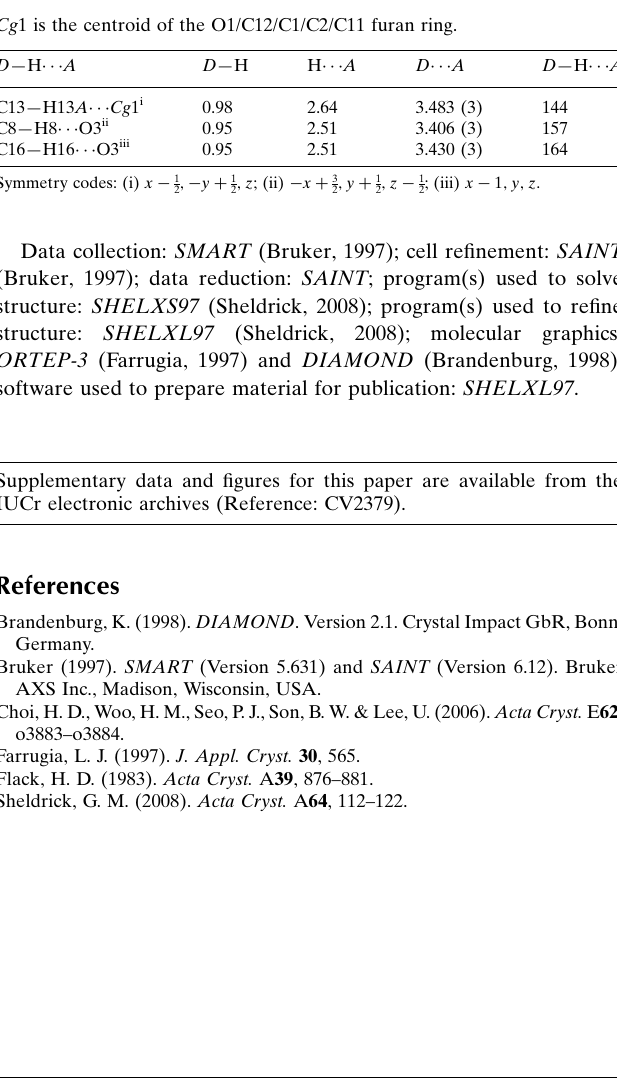
Hydrogen-bond geometry (A˚ , (cid:1)